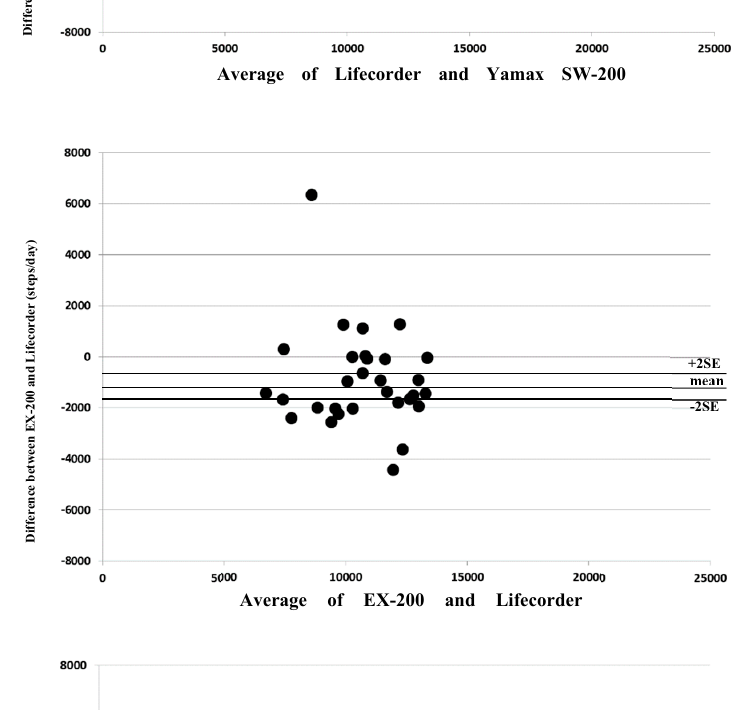
Figure 1. Comparison of step counts recorded by the four pedometers (solid line: identity line, dotted line: regression line).